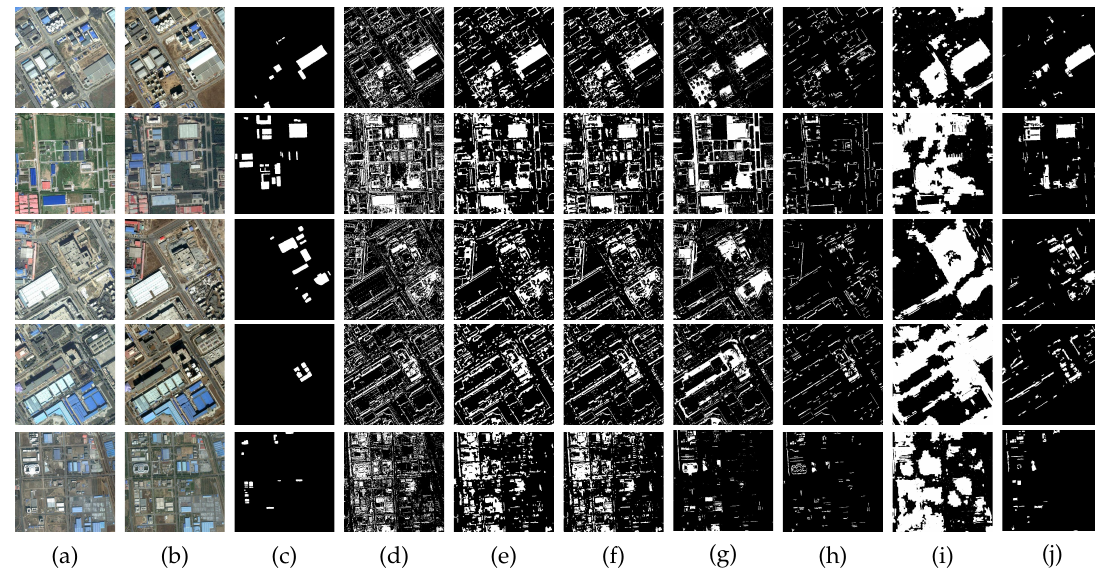
Figure 8. The second image pairs and comparisons of different methods. From up to down: five image pairs (Image1-Image5). (a) and (b) Images from two different time. (c) Ground Truth. (d) EM-based. (e) MRF-based. (f) PCA-based. (g) Parcel-based. (h) MBI-based. (i) SHC-based. (j) Proposed.